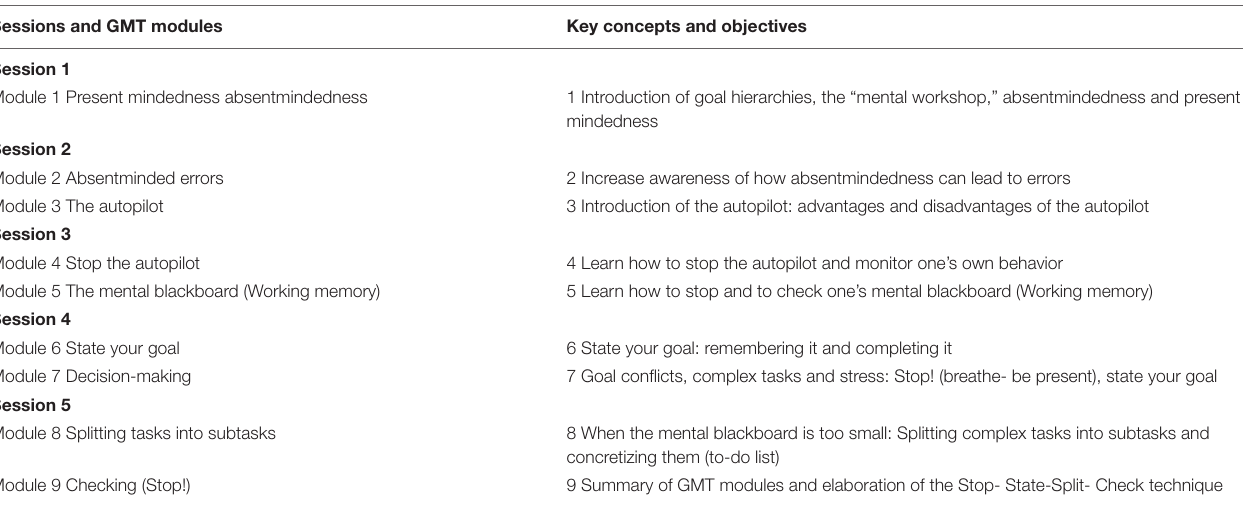
TABLE 2 | Session structure of GMT